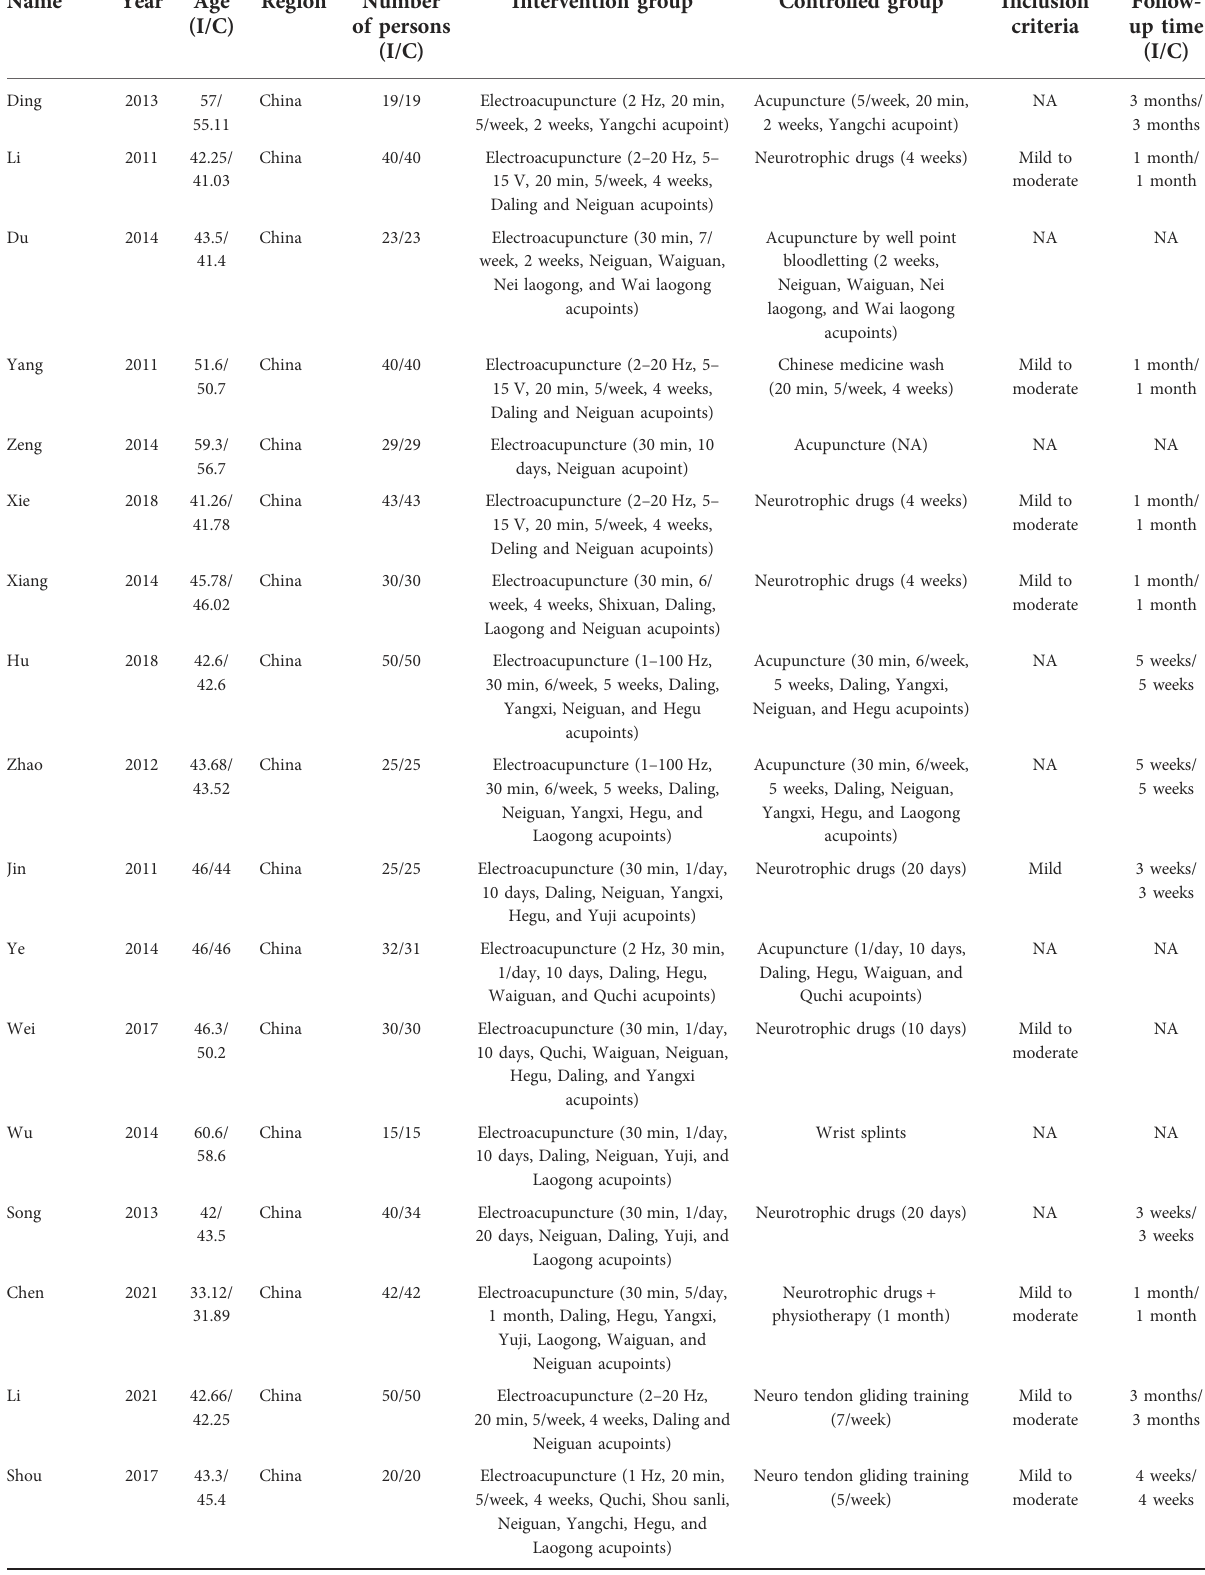
TABLE 1 Basic characteristics of the included literature.